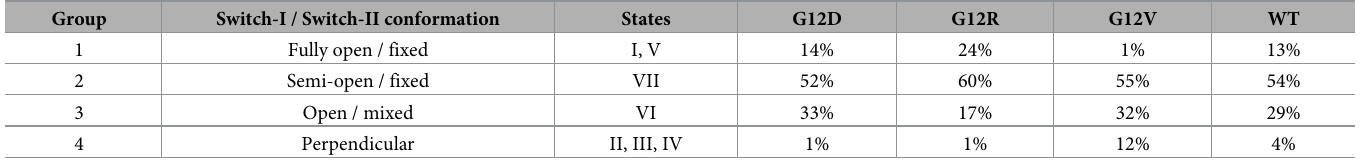
Table 1. Distribution of conformational